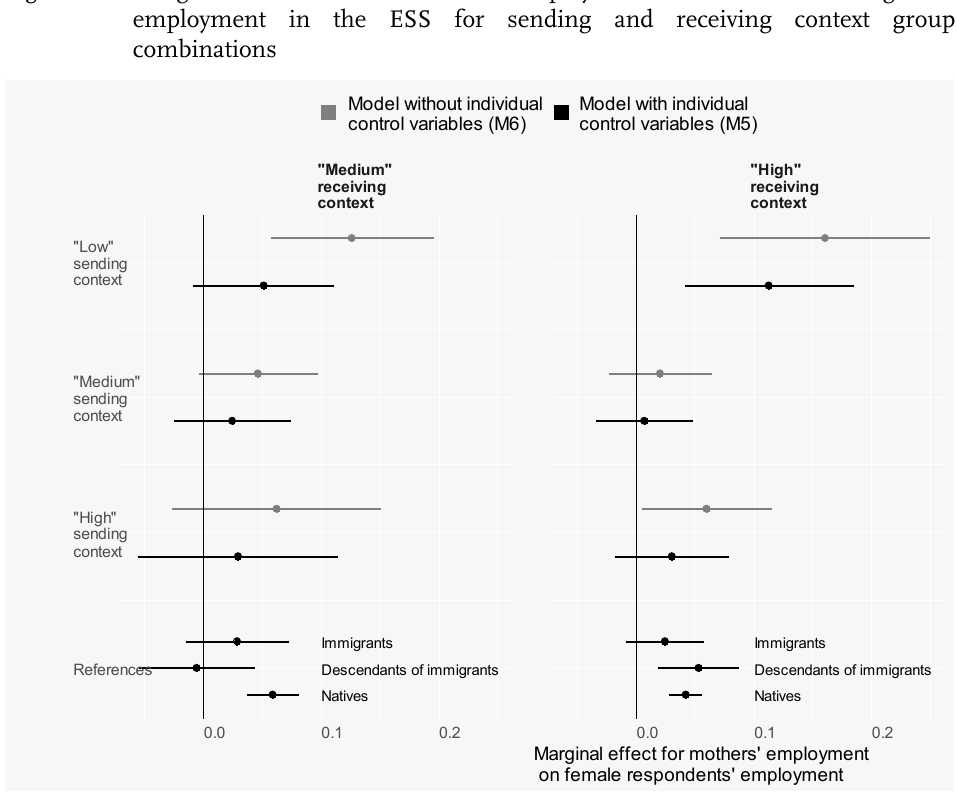
immigrantsImmigrants NativesDescendants of